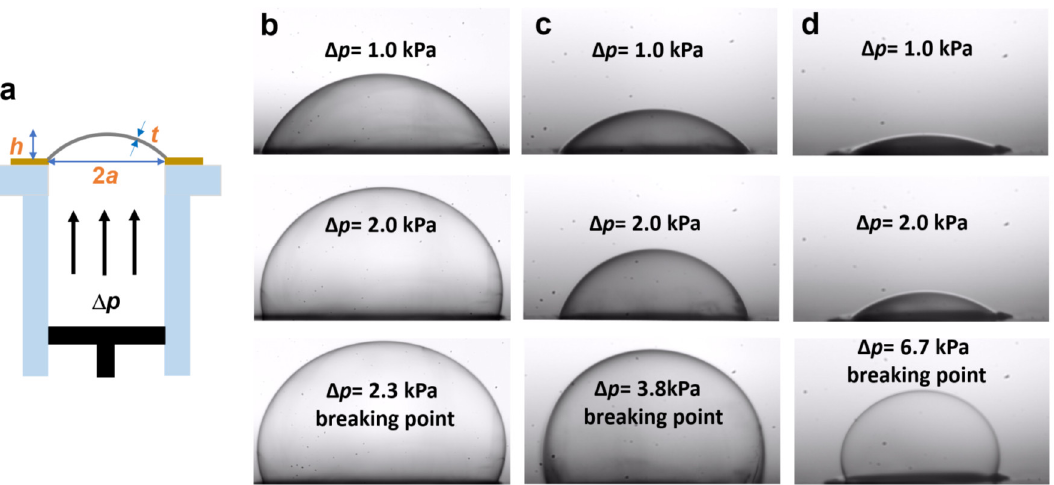
Figure 2. ( a ) Schematic illustration of the bulge test setup along with the relevant parameters (see text for description). ( b – d ) Selected optical images of the deflected PEG membranes, suspended over a circular window with a diameter of 1 mm ( b ), 0.5 mm ( c ), and 0.3 mm ( d ). The bottom image in each series corresponds to the pressure close to the breakdown